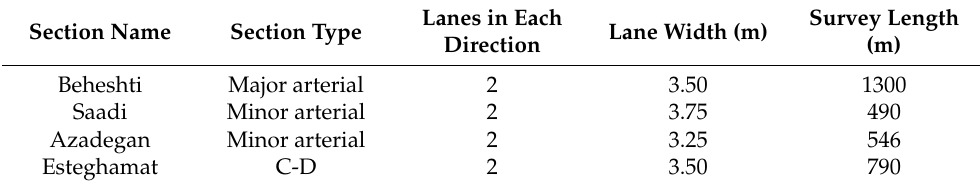
Table 2. Geometric and physical characteristics of the selected roadway